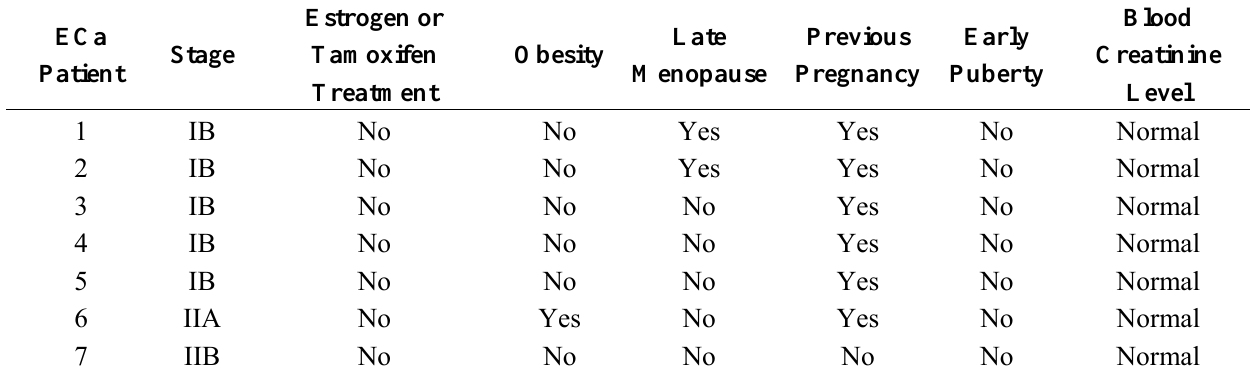
Table 6. Clinical data of ECa patients involved in the